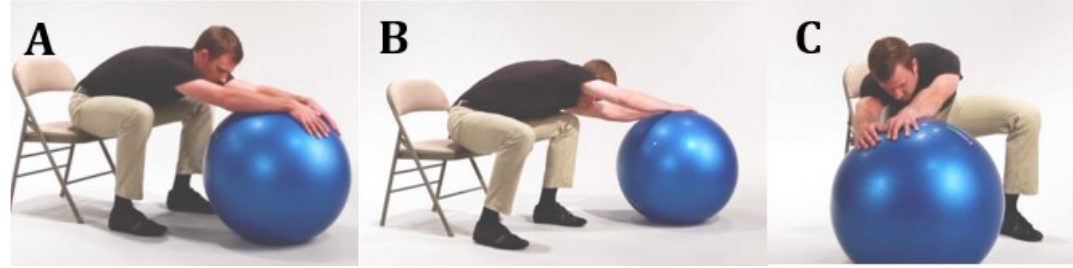
Figure 1 . Swiss Ball Exercise; Medial (A), Lateral Dextra (B), Lateral Sinistra (Sinistra) (Resource: American Heart Association, 2019)